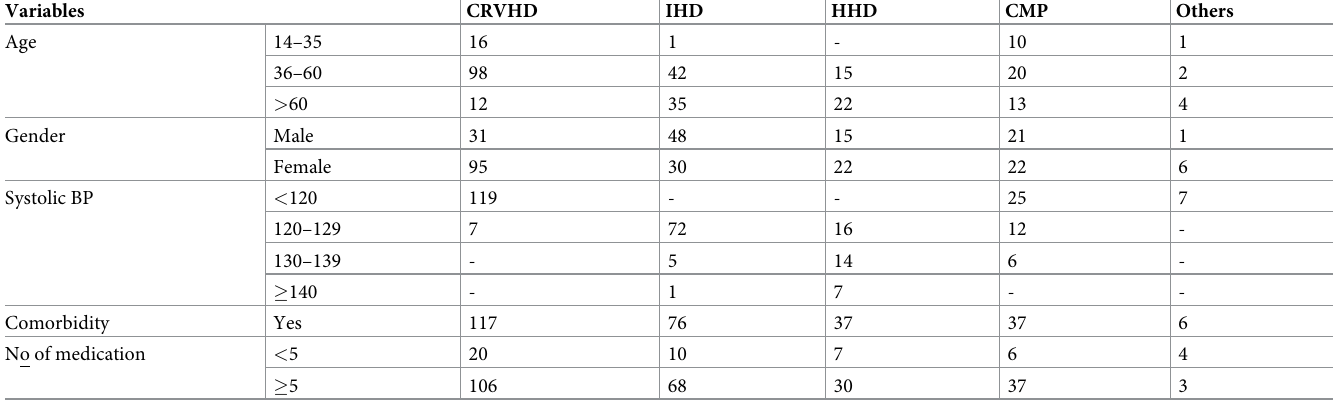
Table 3. Disaggregation of type of patient characteristics with causes of heart failure in patients attending at the cardiac clinic of Tikur Anbessa Specialized Hospi- tal, Addis Ababa, Ethiopia June—August, 2017. Variables